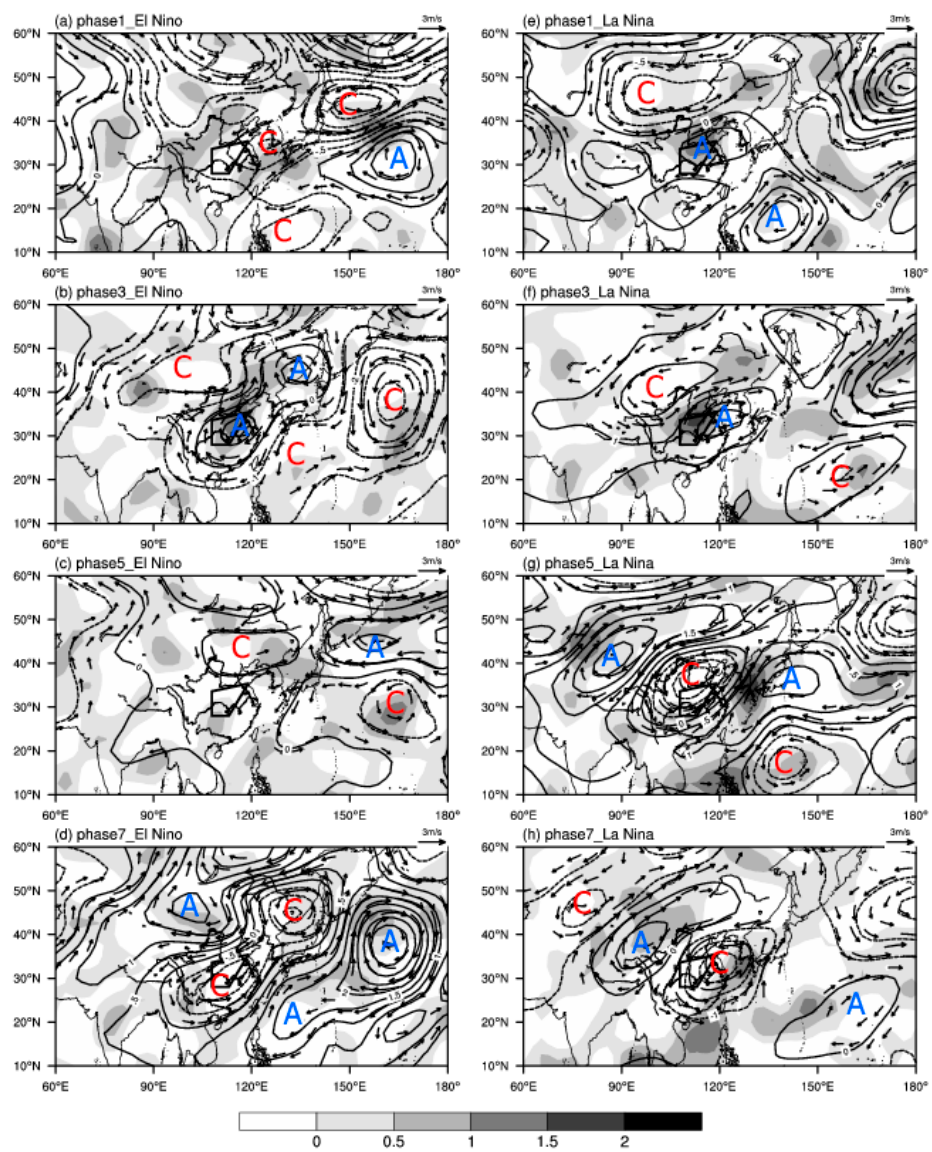
Figure 5. Phase synthesis of 10–20 d low-frequency divergence fields (shaded areas represent divergent areas, units: 10 − 6 s − 1 ), low-frequency stream function fields (contours, units: 10 6 m 2 · s − 1 ) and low-frequency rotational wind fields (vector, units: m · s − 1 ) at 200 hPa during the following summer of CP El Niño ( a – d ) and CP La Niña ( e – h ). The letters ‘C’ (‘A’) represent the centers of the cyclone (anticyclone).